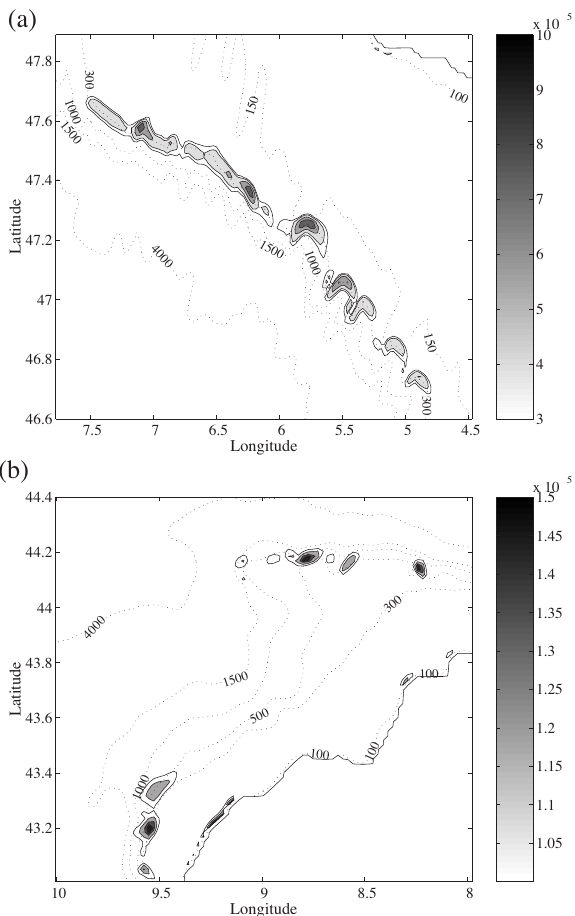
F IG . 6. – Local topography and tidal forcing term, U · ∇ H /H where U → is the barotropic tidal current for the M2 wave and is the bot- tom depth. (a) Over the French continental shelf, isocontours are 3.10 -5 , 4.10 -5 , 6.10 -5 , 8.10 -5 s -1 . The maximum values situated at depth of 300 m, between 5.5 and 7.5°W, defines the main genera- tion areas. (b) Over the Iberian continental slope, isocontours are 1.10 -5 , 1,2.10 -5 , 1,4.10 -5 s -1 . The maximum values are situated at depths of between 500 and 1000 m at the north edge of the Ortegal Cape (44.2°N and 8.5 to